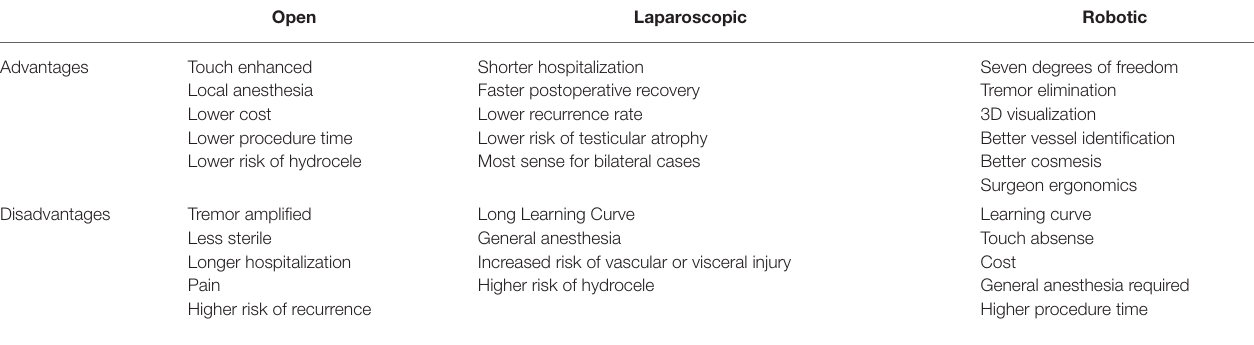
TABLE 1 | Advantages and disadvantages of different surgical approaches. Open